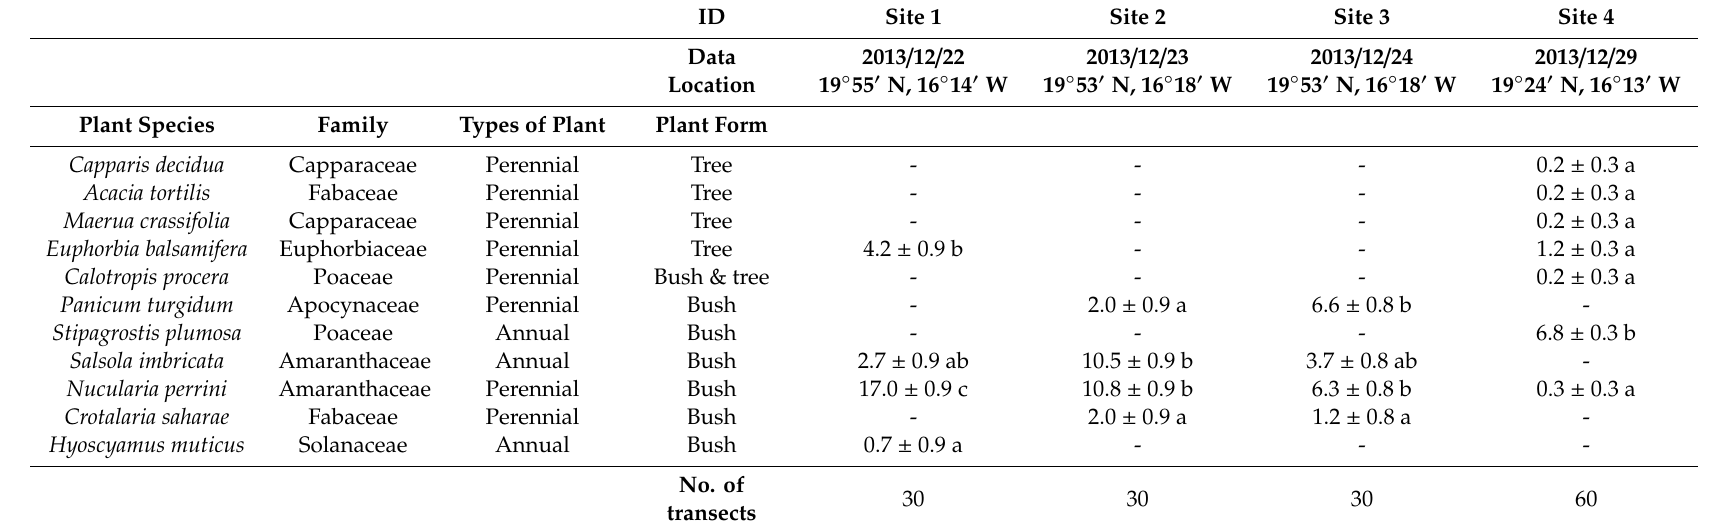
Table 1. Abundance of 11 dominant plant species in four survey sites. Mean ( ± SE) number of plants per belt transect (50 m 2